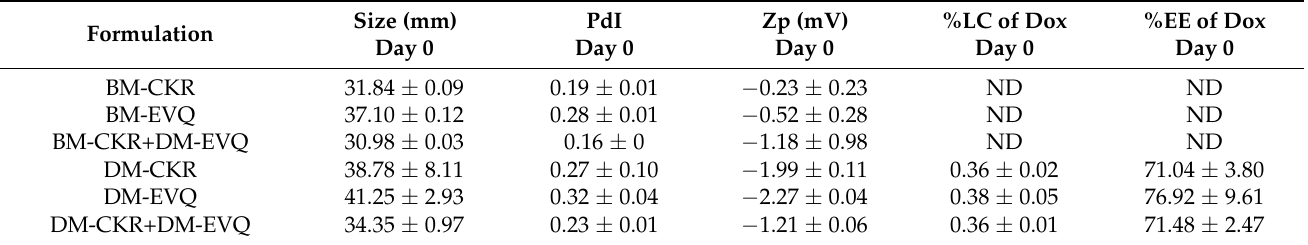
Table 2. Particle size, polydispersity index (PdI), zeta potential (ZP), % entrapment efficacy (EE) , and %loading capacity (LC) of BM-CKR, BM-EVQ, BM-CKR+BM-EVQ, DM-CKR, DM-EVQ, and DM-CKR+DM-EVQ on day 0 at room temperature.